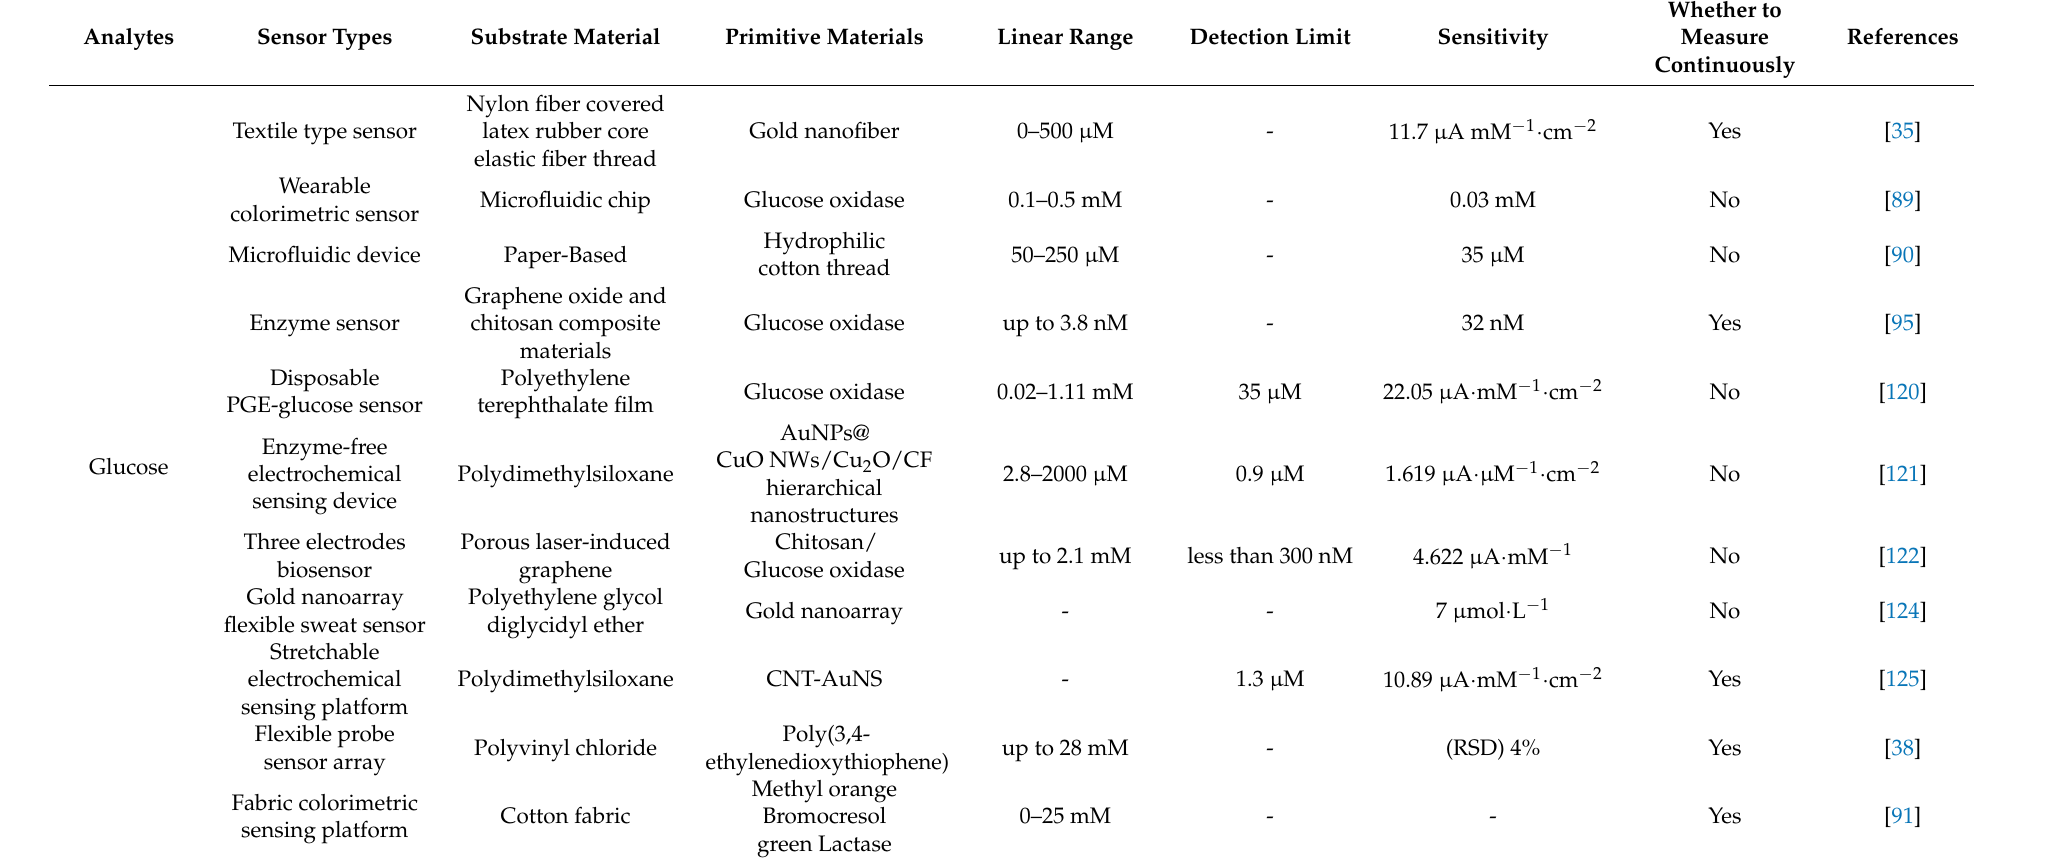
Table 3. The details of the wearable sweat sensors in this